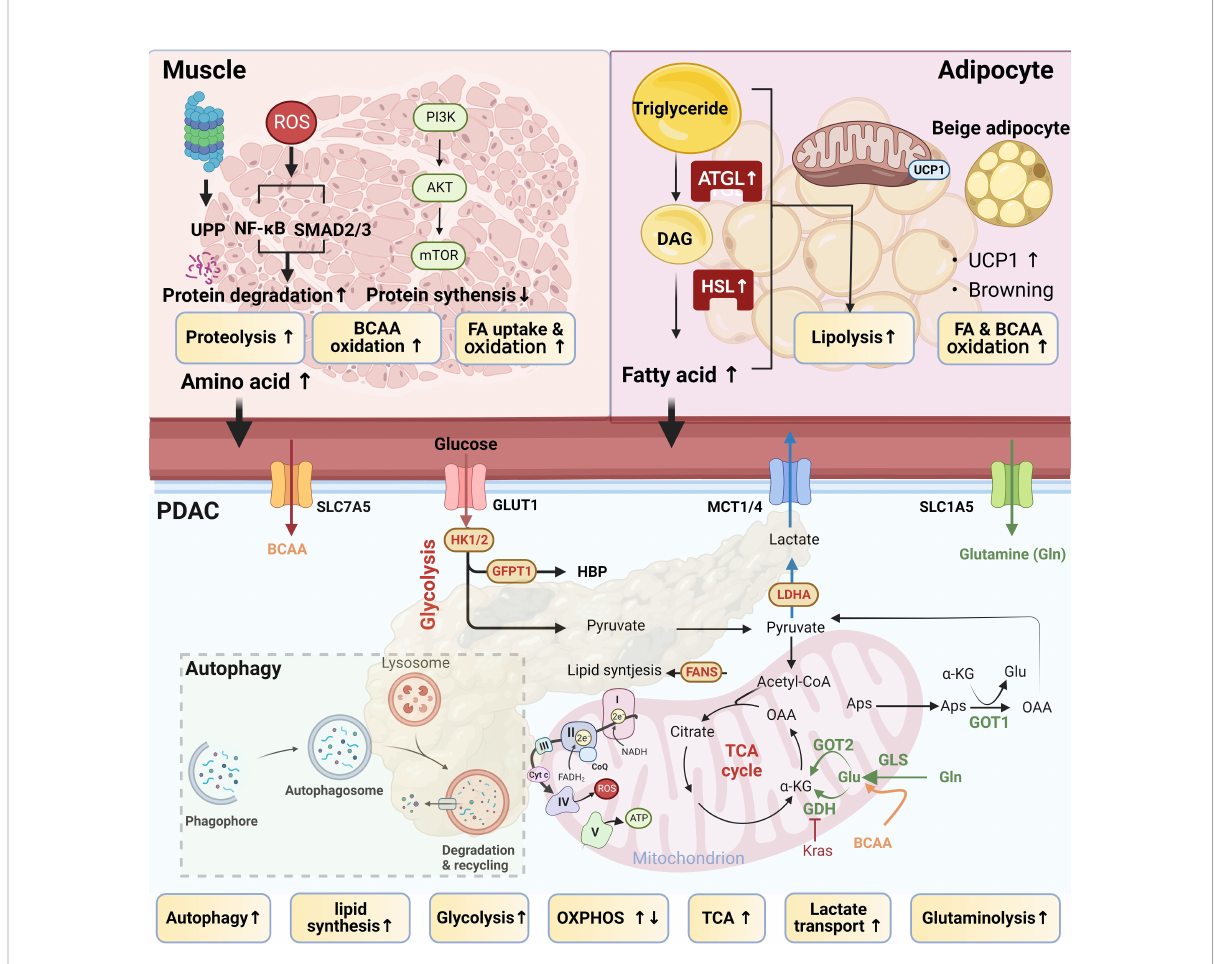
FIGURE 3 Tumor – muscle – adipocyte crosstalk. Pancreatic ductal adenocarcinoma (PDAC)-derived cachexia occurs due to a feedback circuit among tumor, adipocyte, and muscle tissues. In PDAC, tumor ‐ derived factors, including interleukin (IL) ‐ 1, IL-6, IL-8, proteolysis-inducing factor (PIF), lipid mobilization factor (LMF), and tumor necrosis factor ‐ a (TNF a ), enhance proteolysis, lipolysis, and the catabolic state of muscle and adipocytes, leading to adipose and muscle wasting. Tumor cell – triggered metabolic reprogramming in muscle and adipocytes releases metabolic products, such as branched-chain amino acids (BCAA) and free fatty acids (FFAs), to fuel tumor growth. Lipolysis and proteolysis are the two main processes causing adipose and muscle wasting in